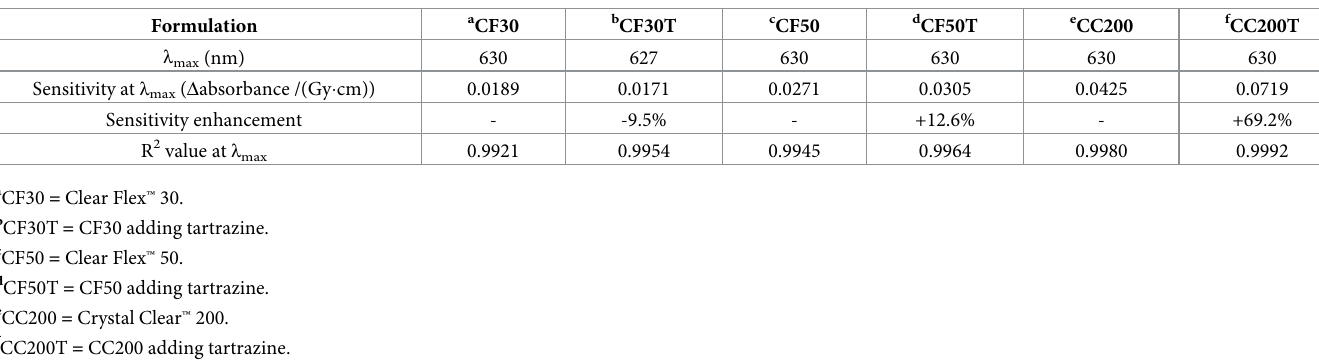
Table 3. For optical absorption measurements, the maximum Δ absorbance at λ max was observed for all fabricated dosimeters. The dose sensitivity was defined as the slope of the dose response curve, which was the maximum Δ absorbance at λ max with absorbed doses. The sensitivity enhancements were defined as the ratio between the slopes of the different fabricated dosimeters.